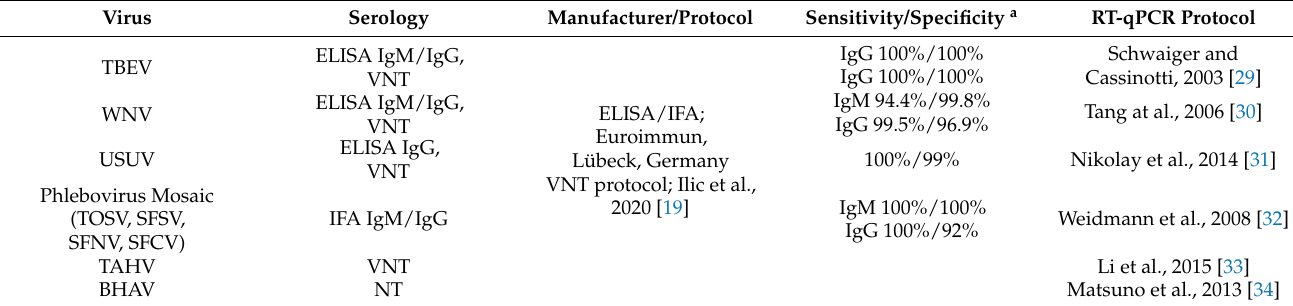
Table 1. Diagnosis of neuroinvasive arboviruses.